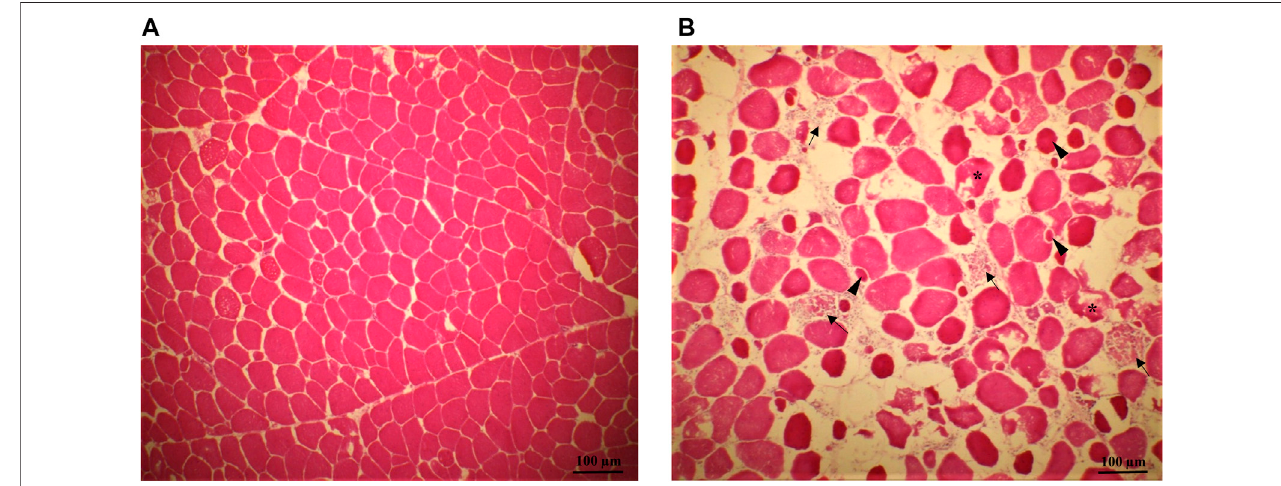
FIGURE 1 | Representative pictures of transversal histological sections from the super fi cial portion of normal [NORM — (A) and Spaghetti Meat fi llets (SM — (B) ]. Muscle tissue from SM fi llets exhibited many of the typical indicators of myodegeneration associated with growth related breast myopathies: muscle fi bers reduced in number, spaced apart and with irregular fi ber sizes; regenerative fi bers (arrowheads), necrosis (asterisks), in fi ltration of in fl ammatory cells and phagocytosis of the remainder of the myo fi bers (arrow).